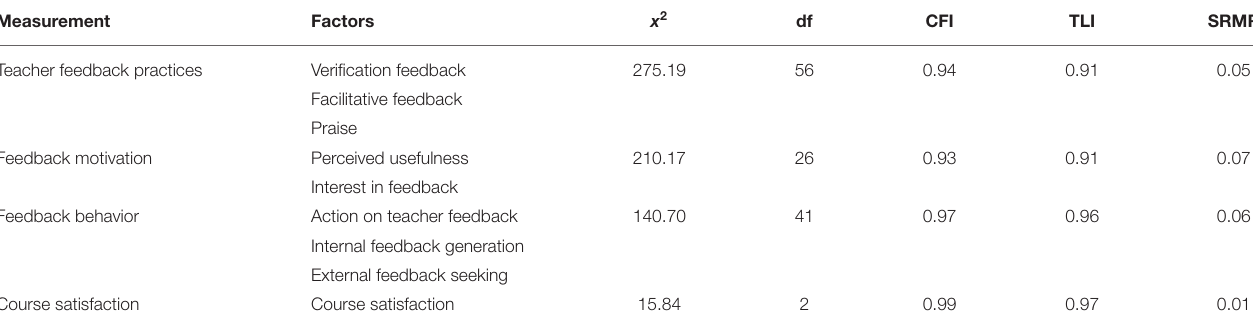
TABLE 1 | Fit indices for measurement models of the measurements.